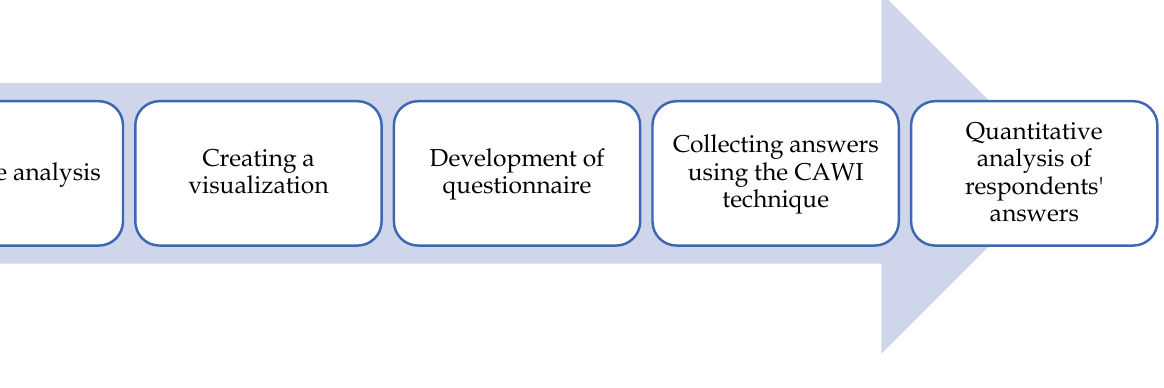
Figure 1. Study scheme.